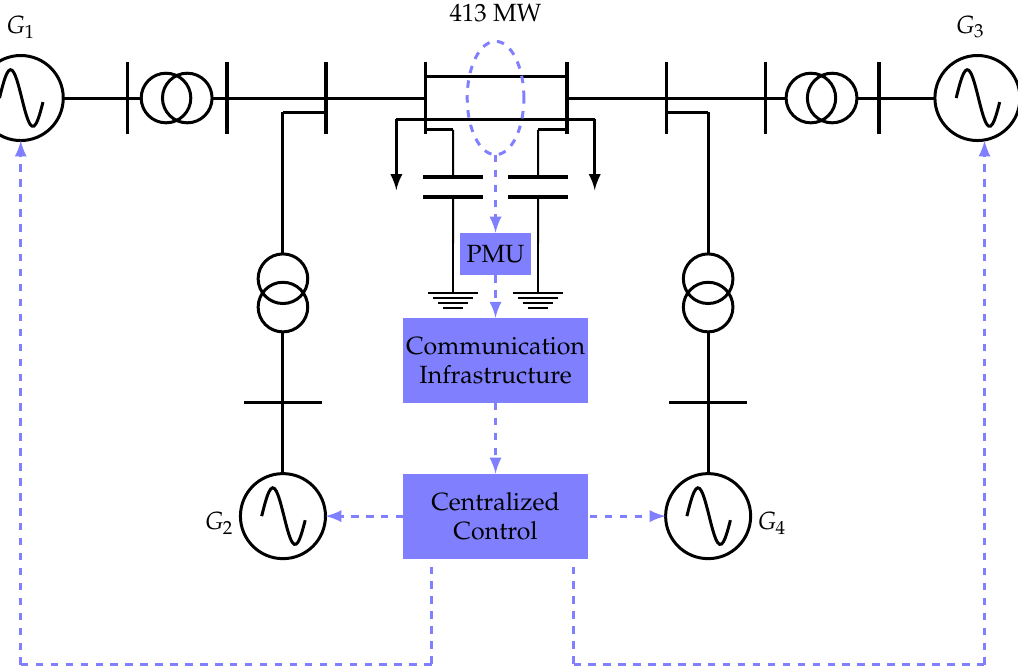
Figure 6. Kundur’s test system with the control